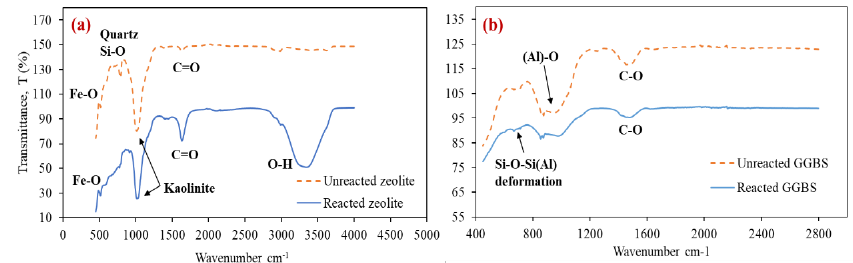
Figure 10. FTIR spectra of ( a ) zeolite before and after reaction, ( b ) ground granulated blast-furnace slag (GGBS) before and after reaction with acid mine drainage.